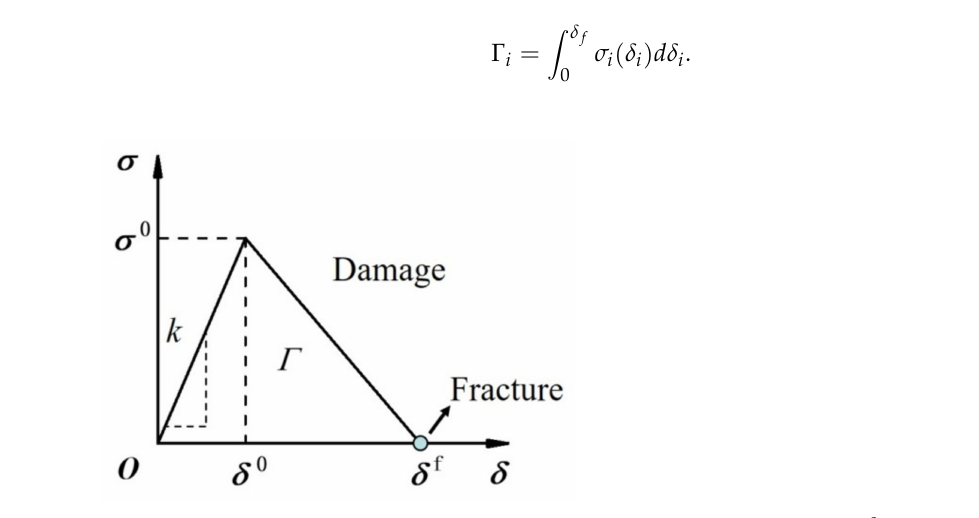
Figure 2. Interfacial stress σ -displacement δ relation with interface strength σ 0 , toughness Γ , initial stiffness k , damage displacement δ 0 and fracture displacement δ f